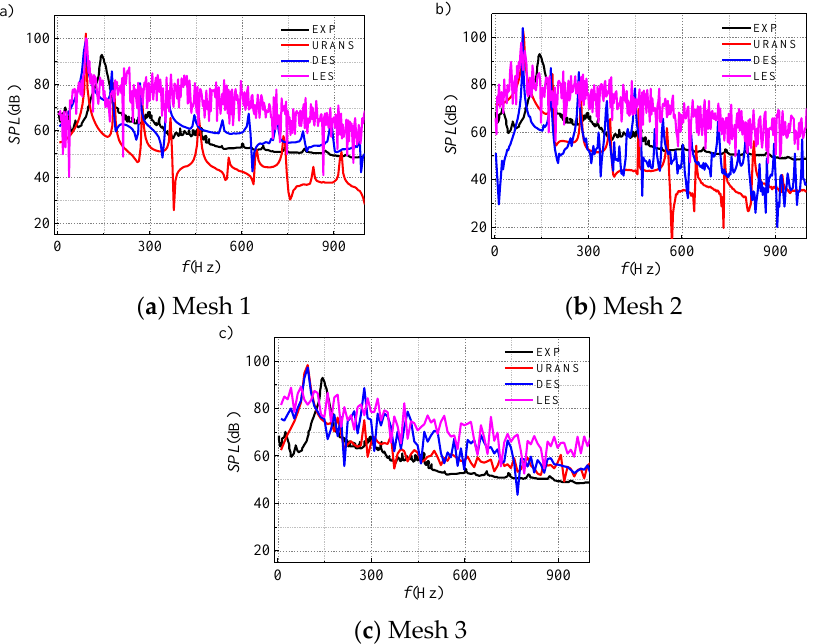
Figure 7. The sound pressure level (SPL) distribution at the monitoring point.